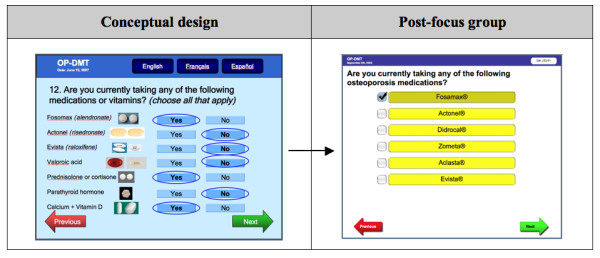
RAQ question about conditions.